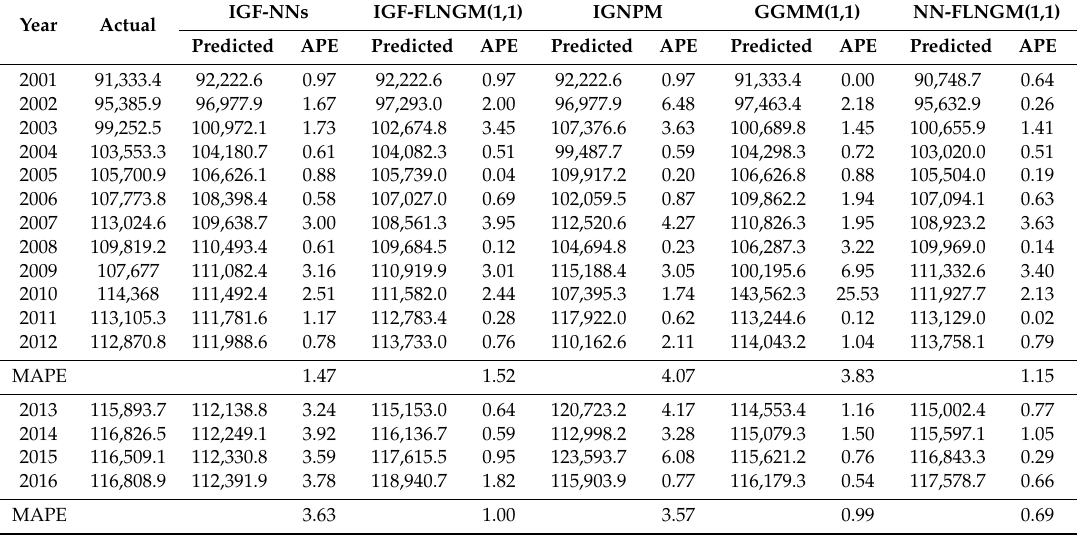
Table 3. Forecasting accuracy of di ff erent interval grey number forecasting models for Case II (unit: 104 kLOE).